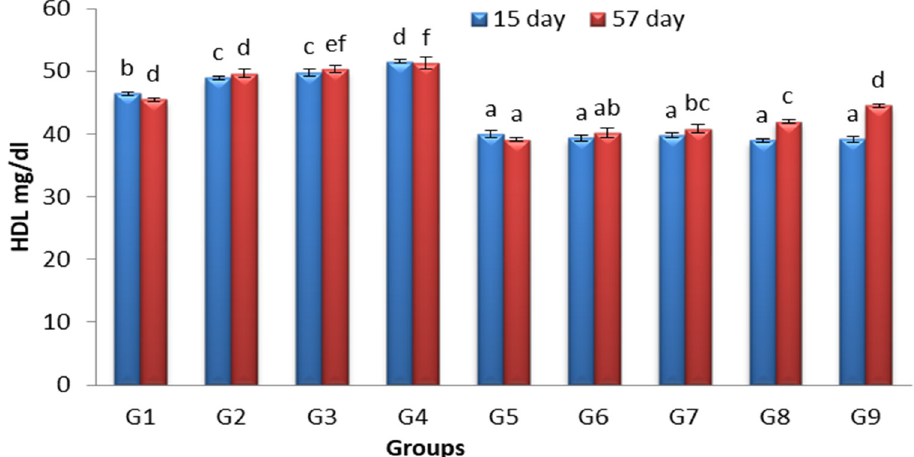
Figure 4. The influence of L. plantarum (Lp), L. casei (Lc), S. platensis (Sp) and their combination on high-density lipoprotein (HDL-C) level in albino mice (mg/dL) at 15 and 57 days. Error bars represent SE of mean. G1: regular diet (RD); G2: RD + Lp + Lc; G3: RD + Sp; G4: RD + Lp + Lc + Sp; G5: high-cholesterol diet (Ch); G6: Ch + Lp + Lc; G7: Ch + Sp; G8: Ch + Lp + Lc + Sp; G9: Ch+ rosuvastatin. Bars with different superscript are significantly different ( p < 0.05).